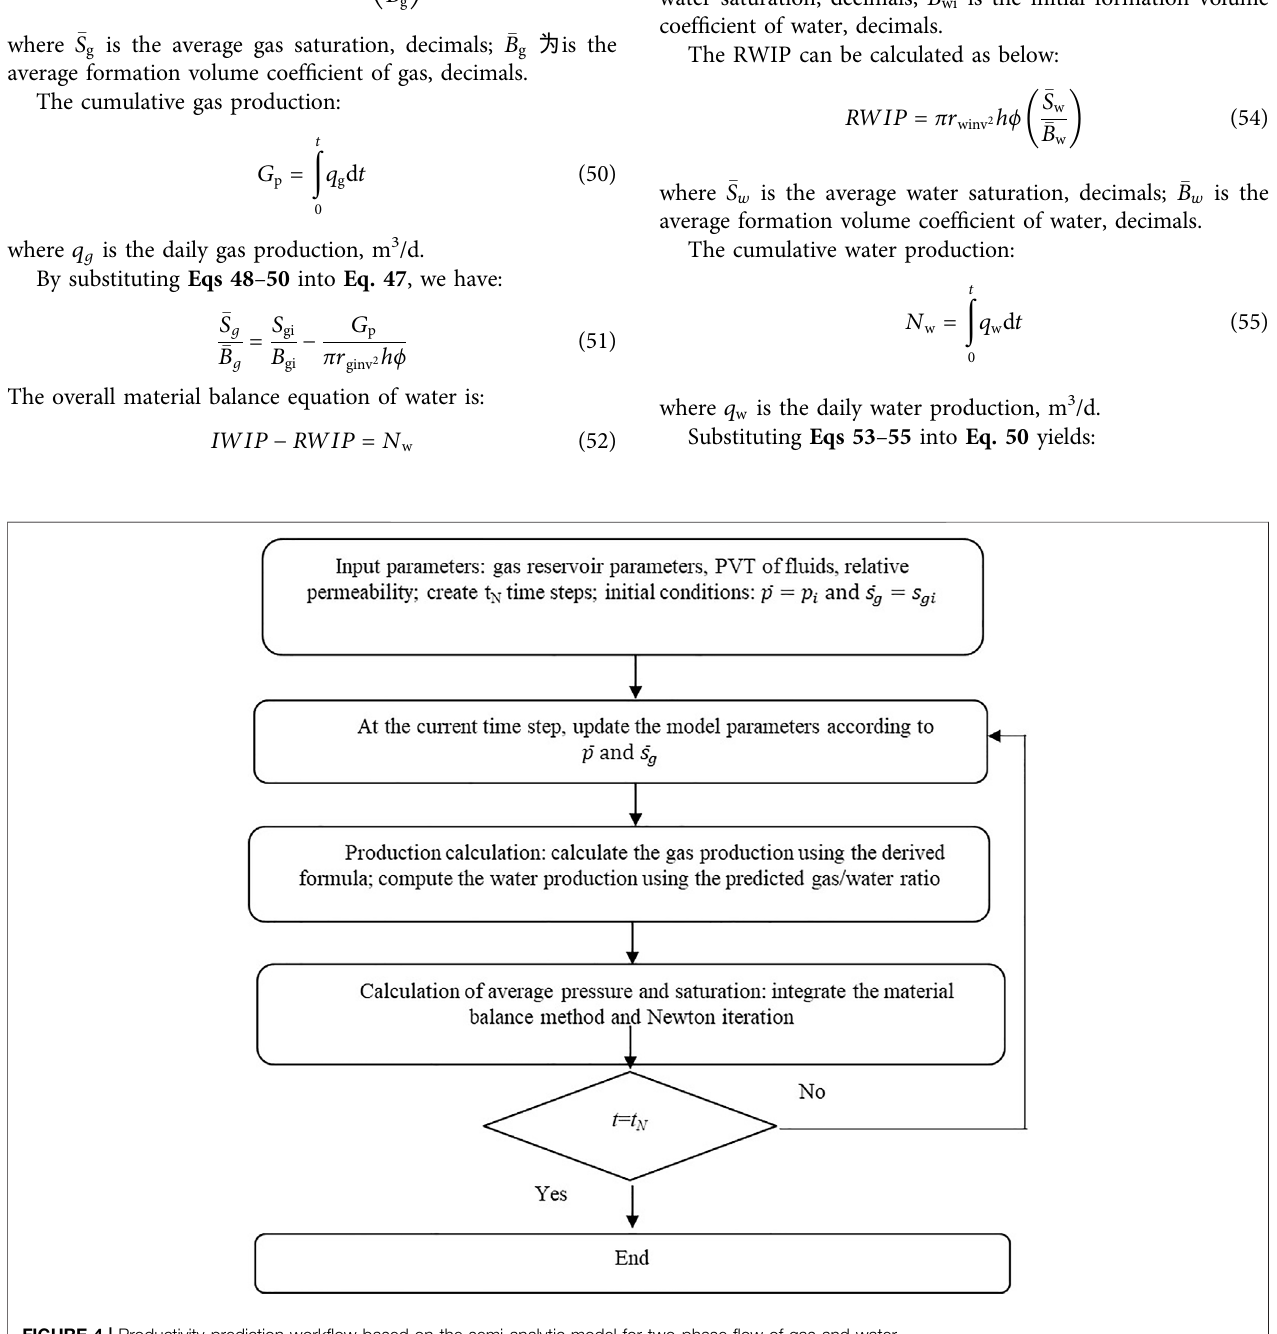
FIGURE 4 | Productivity prediction work fl ow based on the semi-analytic model for two-phase fl ow of gas and water.